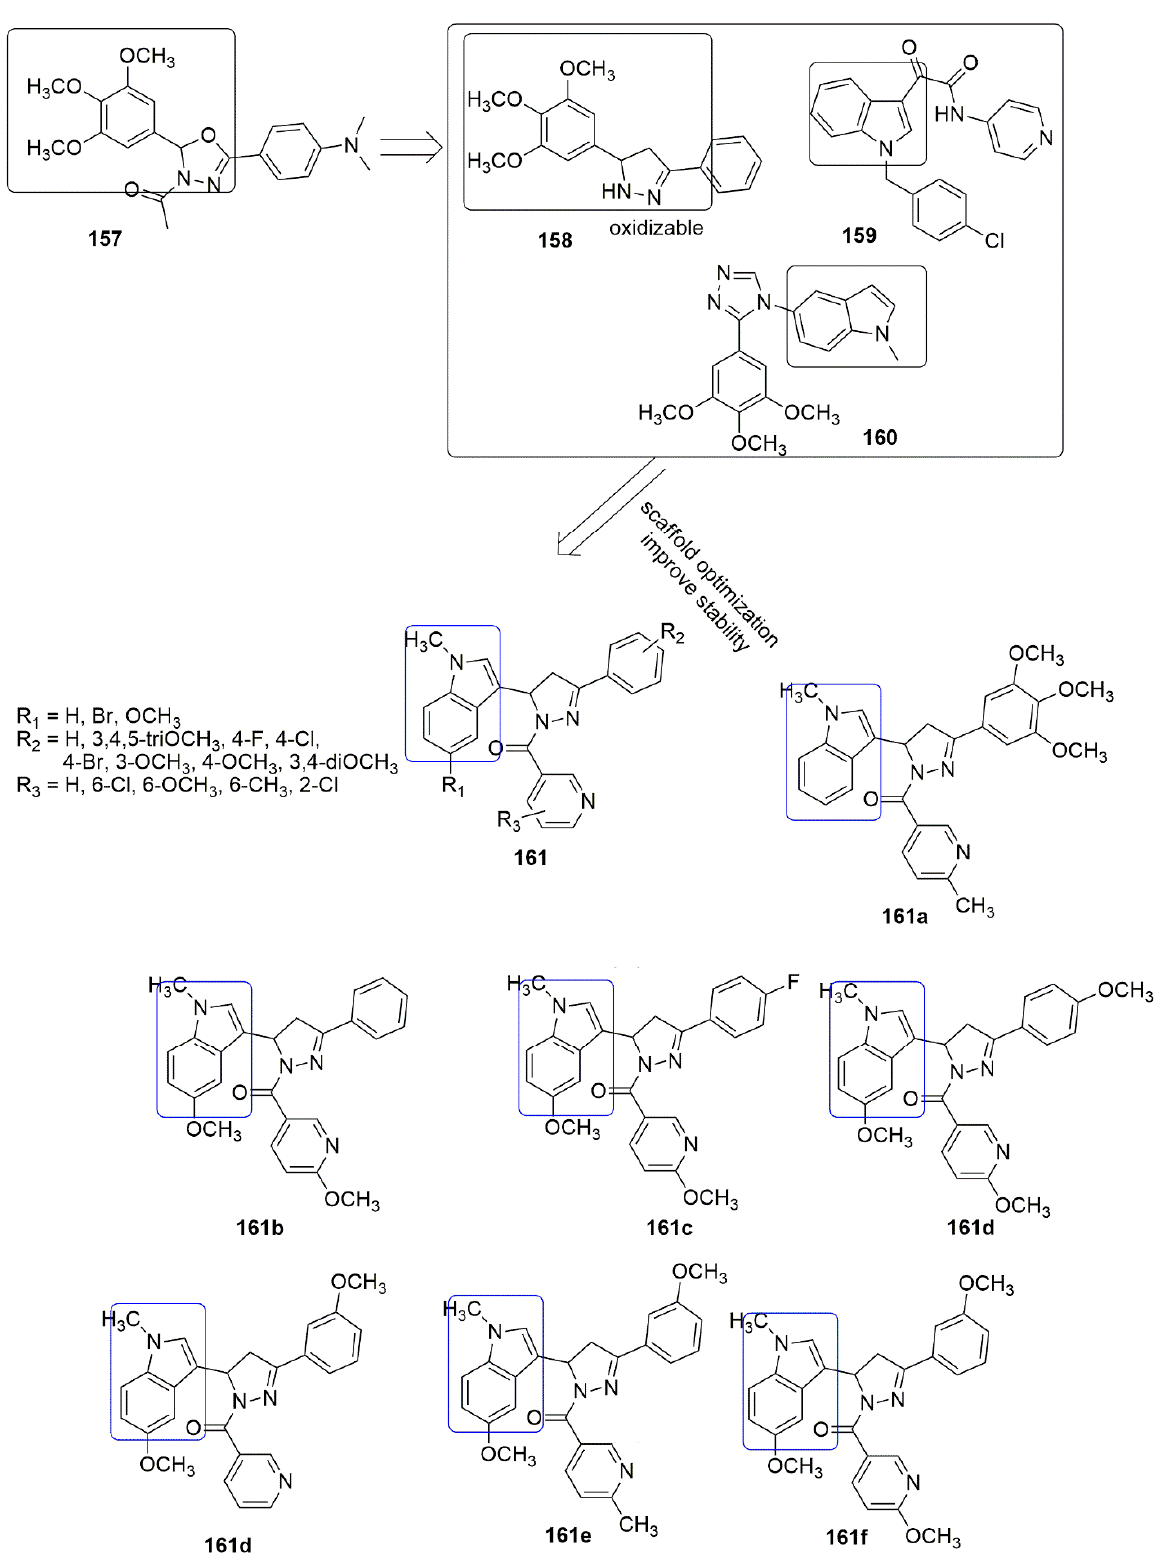
Figure 42. Nicotinoyl pyrazoline derivates bearing N -methyl indole exhibiting antiproliferative Table 9. IC50 (µM) values of active hybrids (161a–161g) against sensitive cancer cell lines and tubulin polymerization.